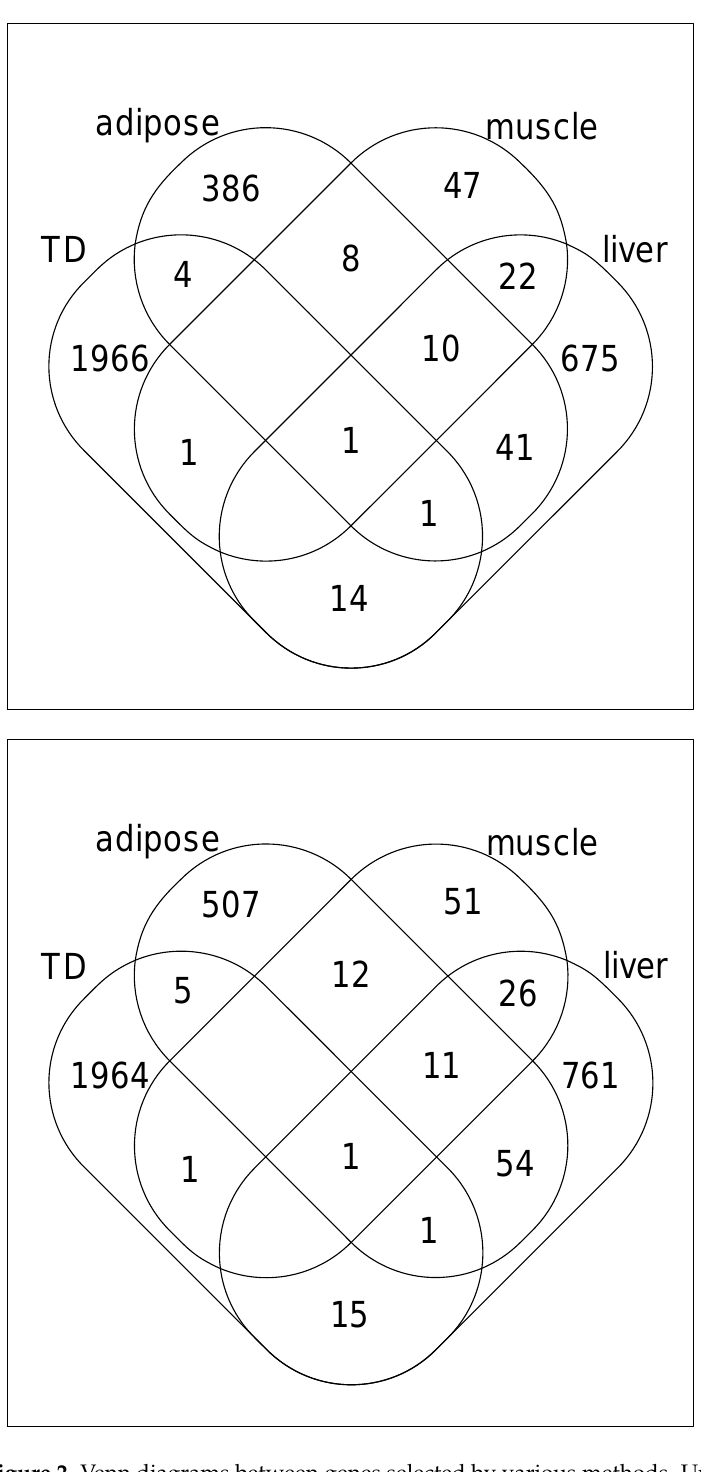
Figure 2. Venn diagrams between genes selected by various methods. Upper: t test, lower: